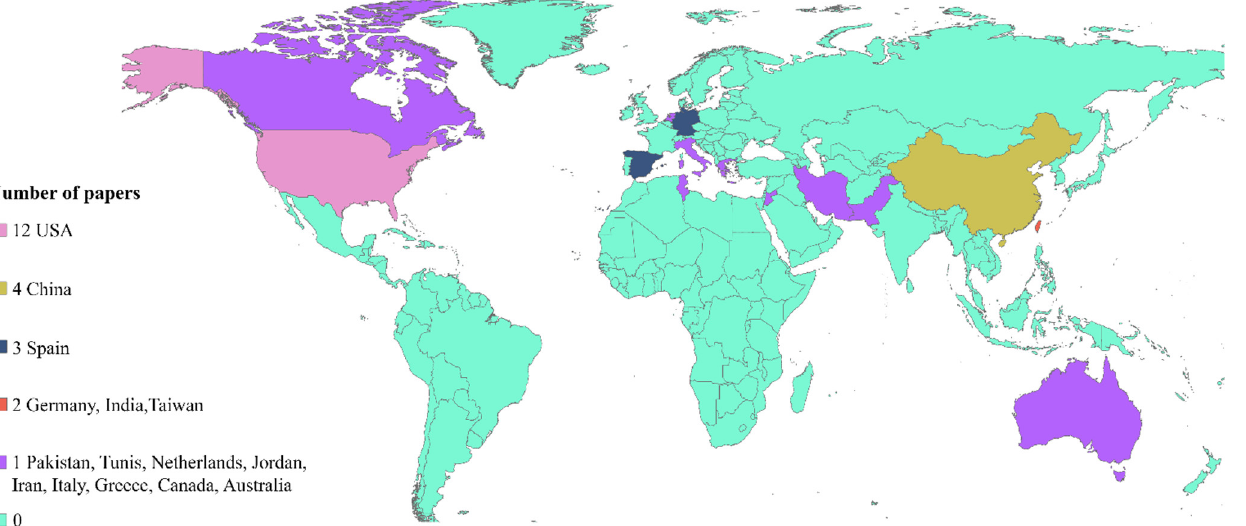
Figure 2. Annual publications of methods for estimating groundwater pumping. * Undeveloped countries.